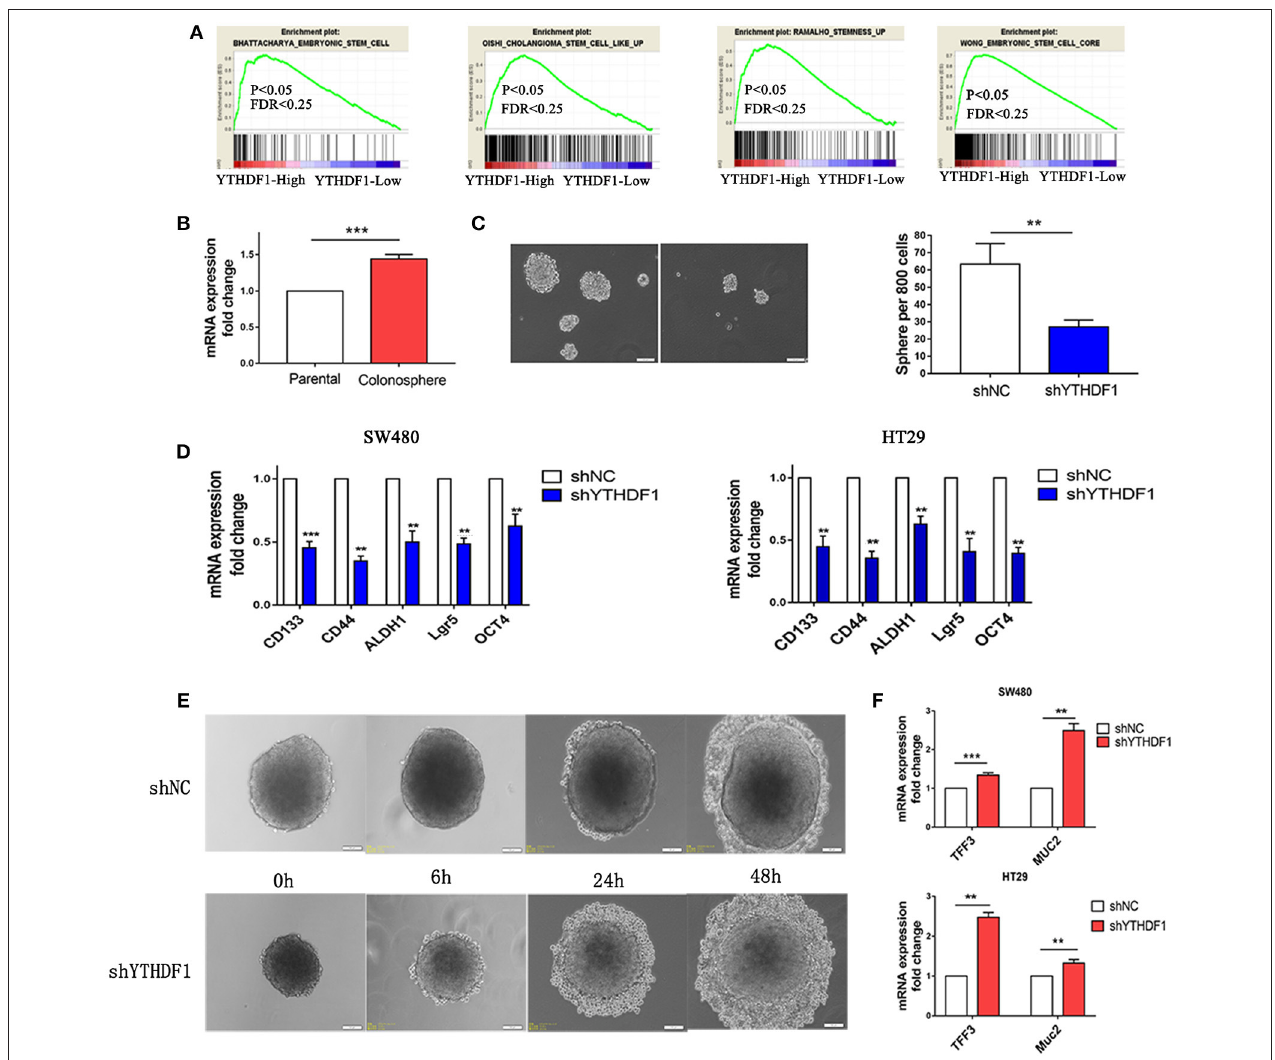
FIGURE 5 | YTHDF1 Is Overexpressed in Colonospheres and Regulates Stem cell-like activity. (A) GSEA plot showing YTHDF1 expression level was positively correlated with activated stemness related gene signatures (B) Real-time PCR analysis the YTHDF1 expression between parental HT29 cell and HT29 colonospheres cells (C) Representative images and quantification of spheres formed by HT29 cells (scale bar, 100 µ m;). (D) Real-time PCR analysis of stemness-related markers in CRC cells. (E) Representative images of HT29 colonospheres cultured under differentiation-inducing conditions. (scale bar, 100 µ m;) (F) Real-time PCR analysis of enterocyte markers in CRC cells (** p < 0.01; *** p <